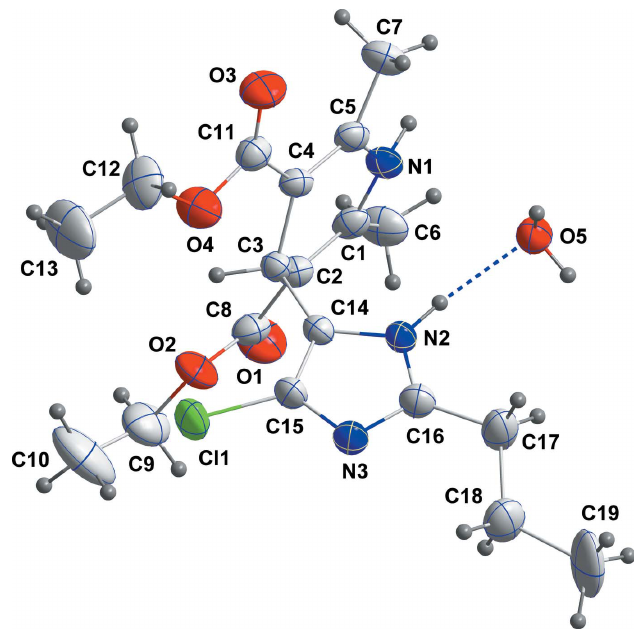
Figure 1 The asymmetric unit with the atom-labelling scheme and 50% probability ellipsoids. Only the major disorder components are shown. The N— H (cid:2)(cid:2)(cid:2) O hydrogen bond to the water molecule of crystallization (Table 1) is shown as a dashed line.